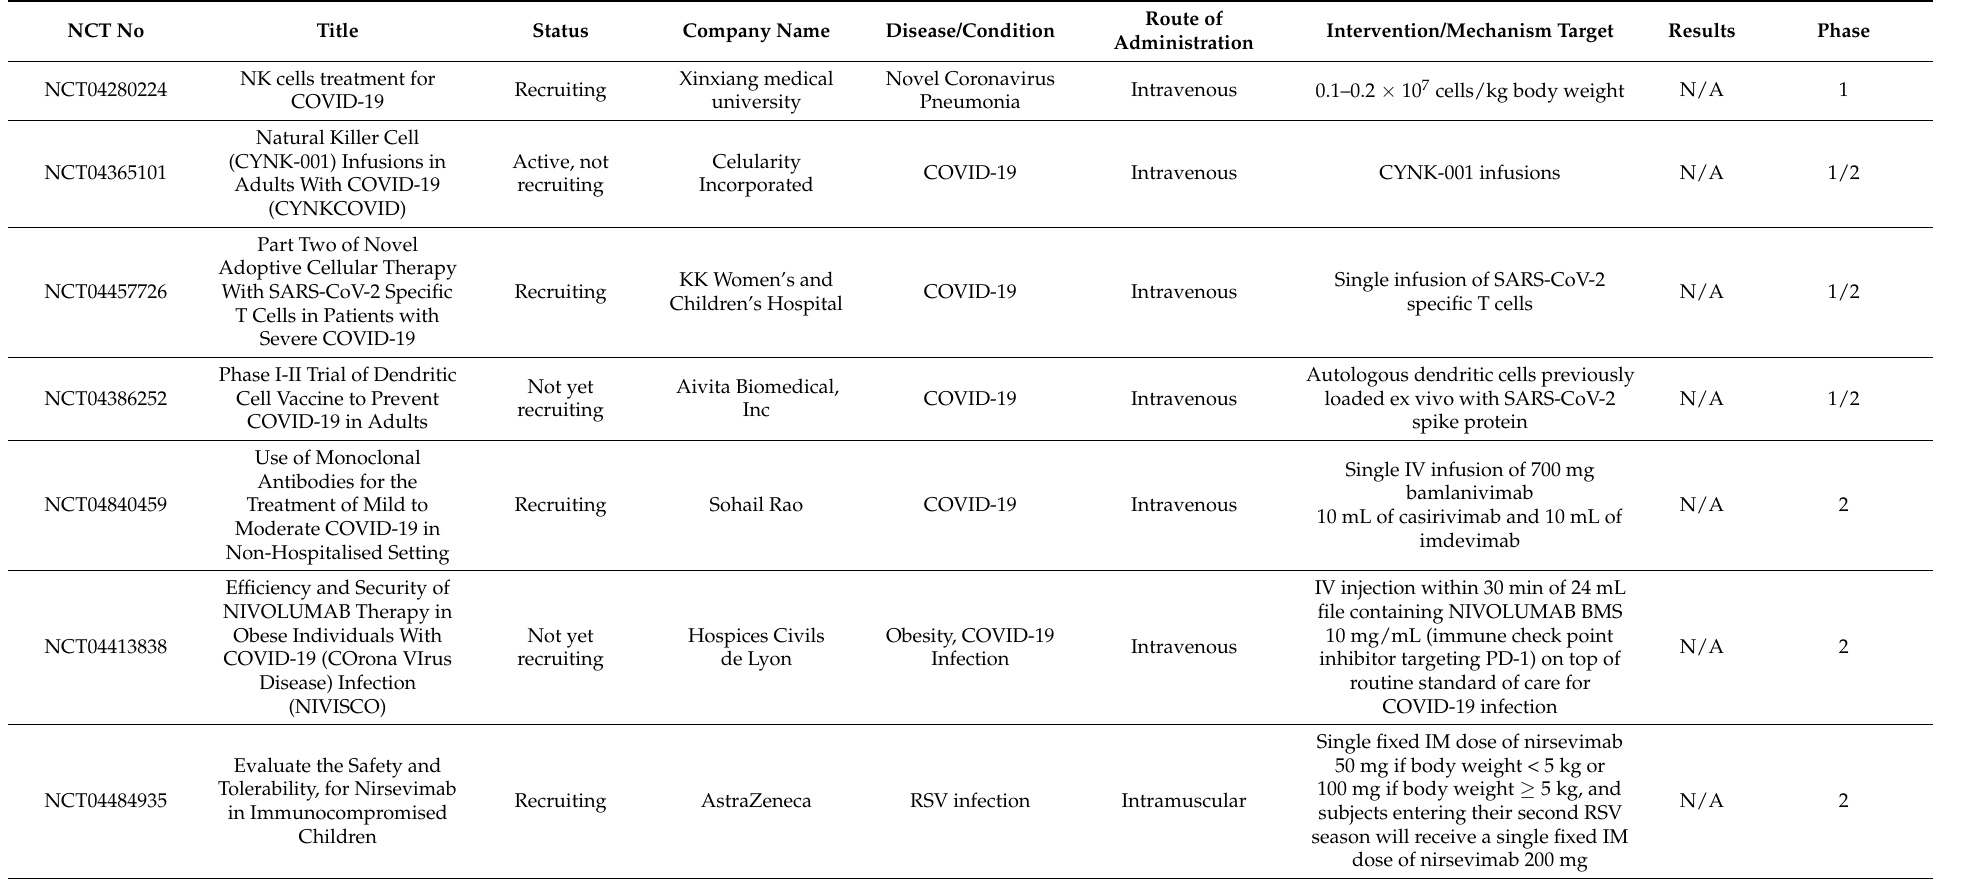
Table 1. Cellular Immunotherapy clinical trials for respiratory